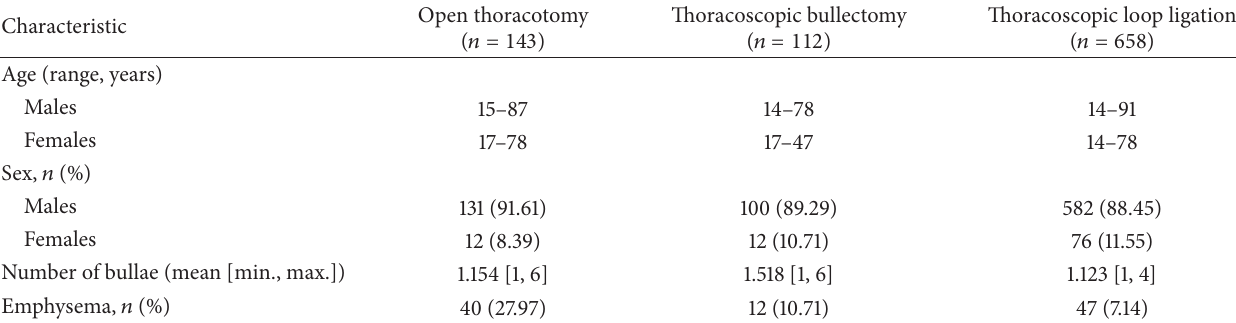
Table 1: Baseline characteristics.